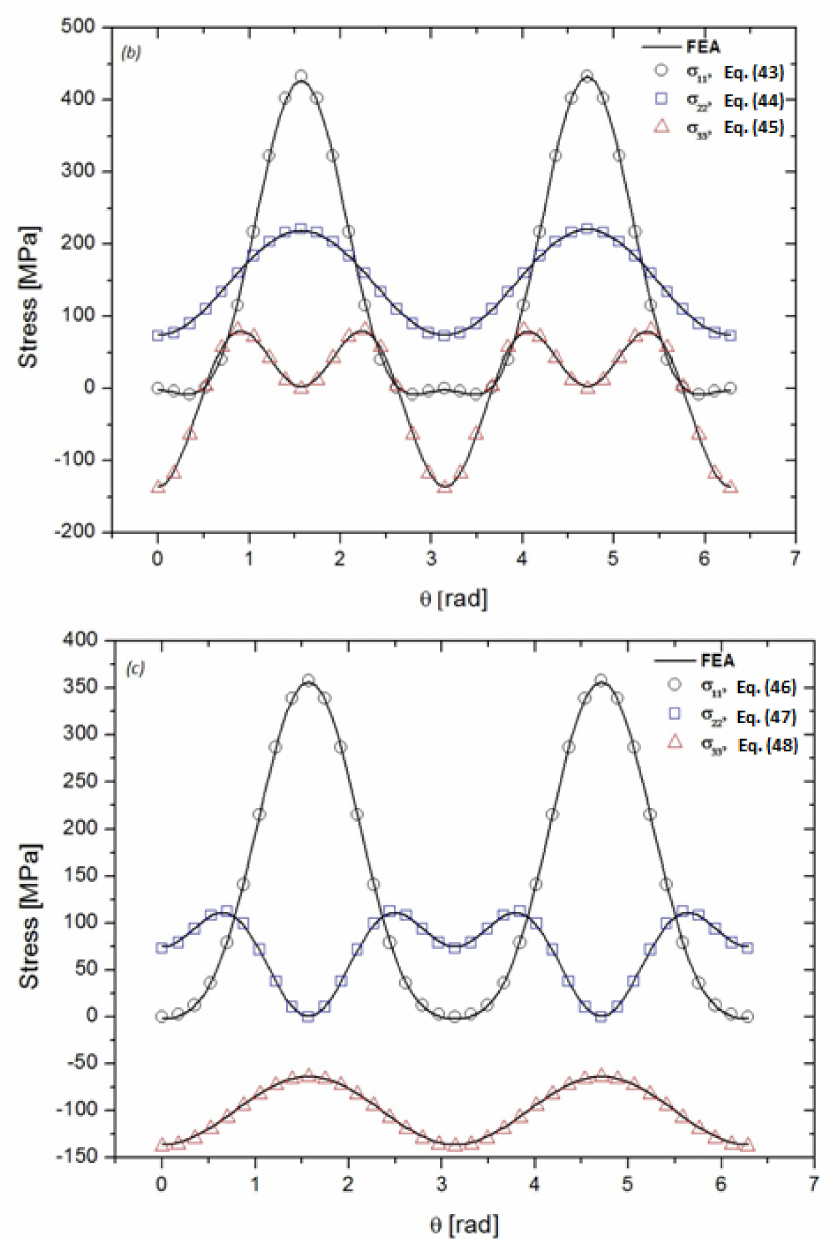
Figure 7. Variations of stress components around the spherical cavity: ( a ) equator x 1 = 0, ( b ) equator x 2 = 0, and ( c ) equator x 3 = 0. Porosity radius ρ = 0.5 mm, dimensionless geometric ratio of the cylinder κ = 15.5, and dimensionless depth ∆ / t =